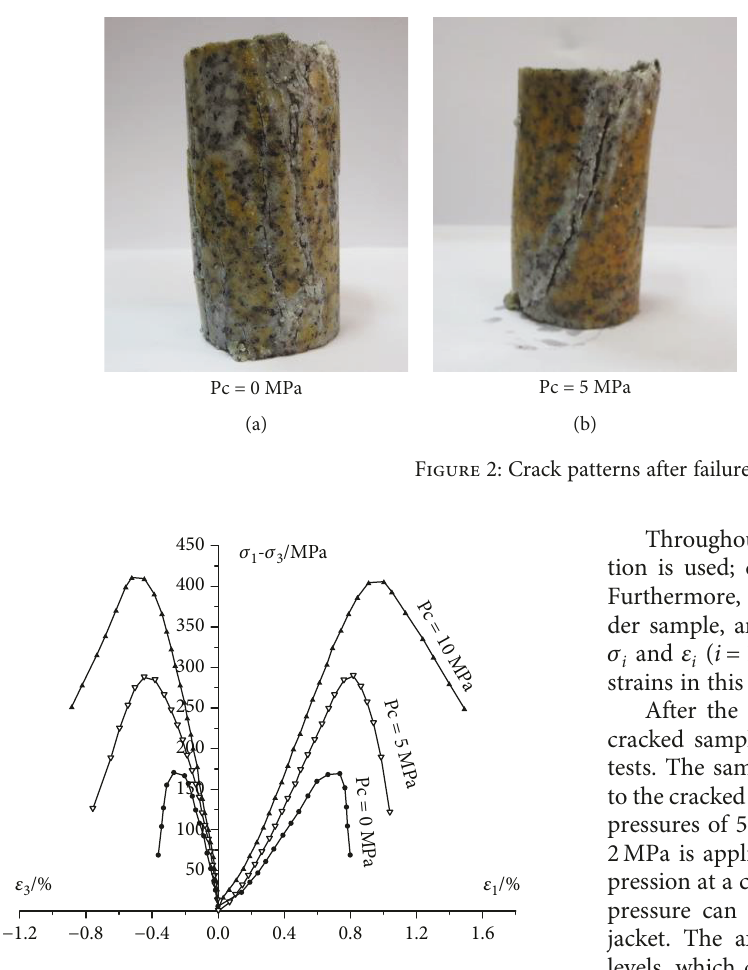
Figure 3: Typical stress-strain curves of the triaxial compression tests.